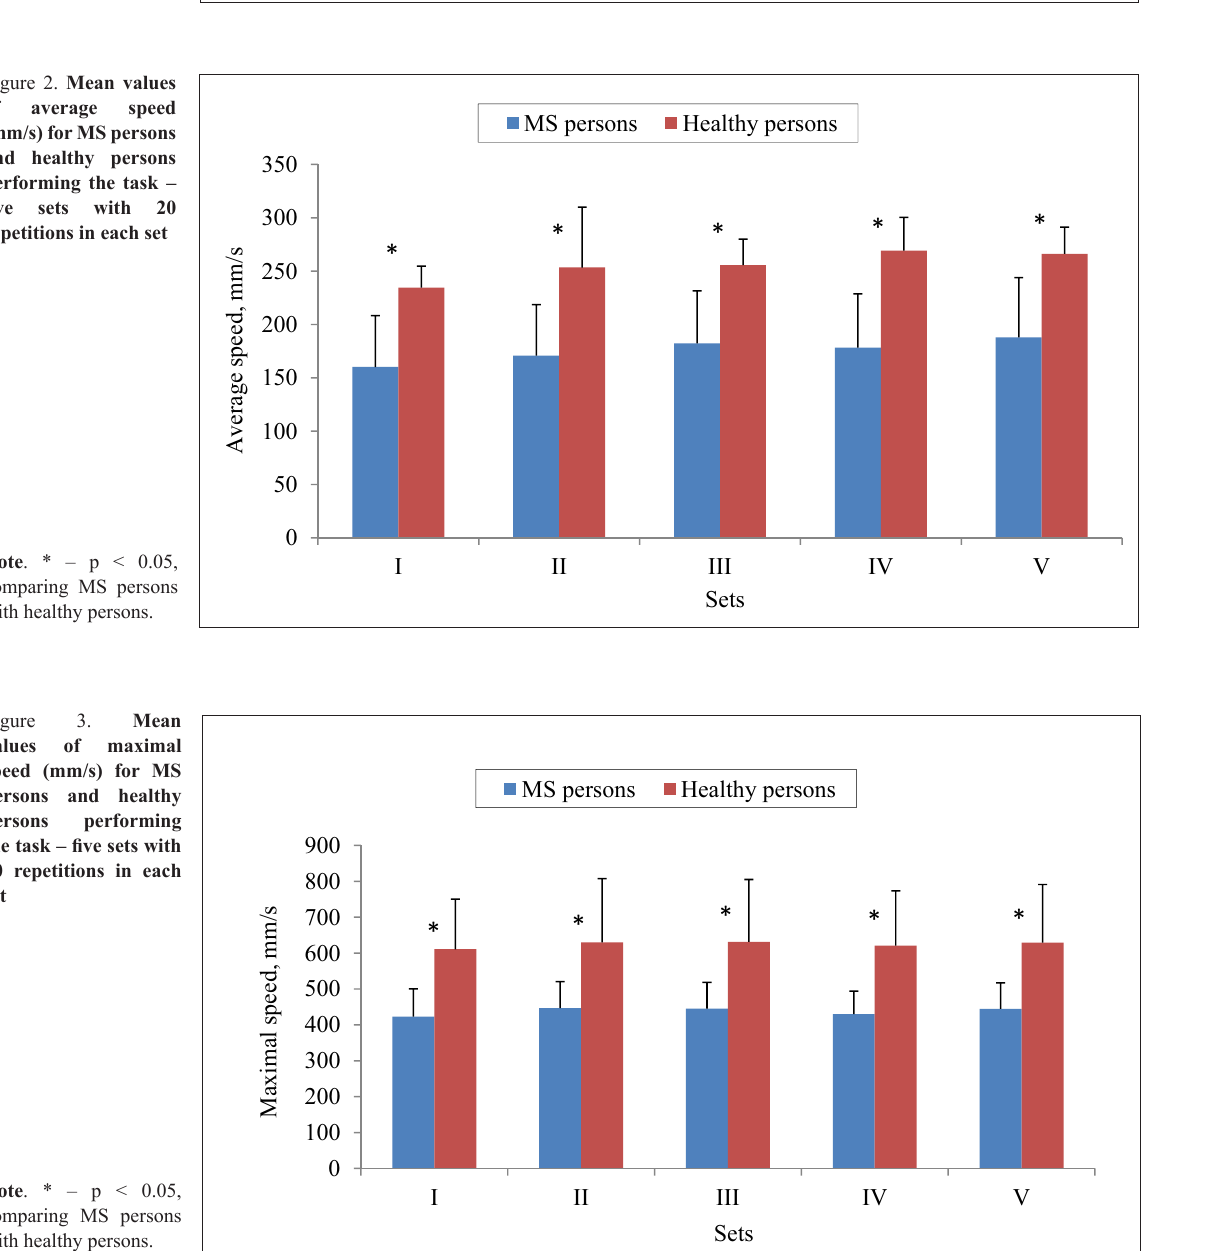
Figure 3. Mean values of maximal speed (mm/s) for MS persons and healthy persons performing the task – five sets with 20 repetitions in each set